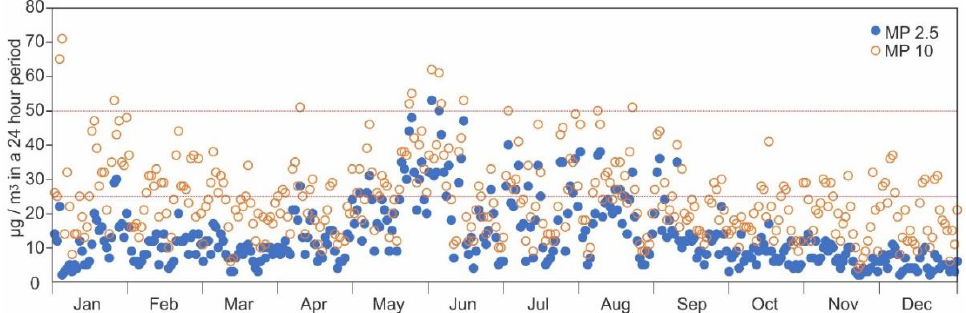
Figure 5. Particulate matter concentrations, PM 2.5 and PM 10 in 24-h periods measured during 2020